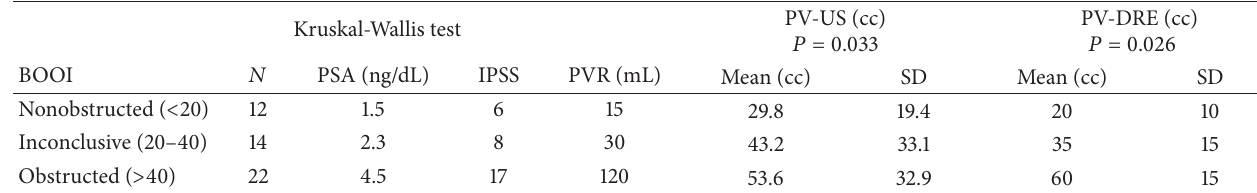
Table 2: BOOI ranking of PV US, PV DRE, PSA, IPSS, and PVR means. Kruskal-Wallis